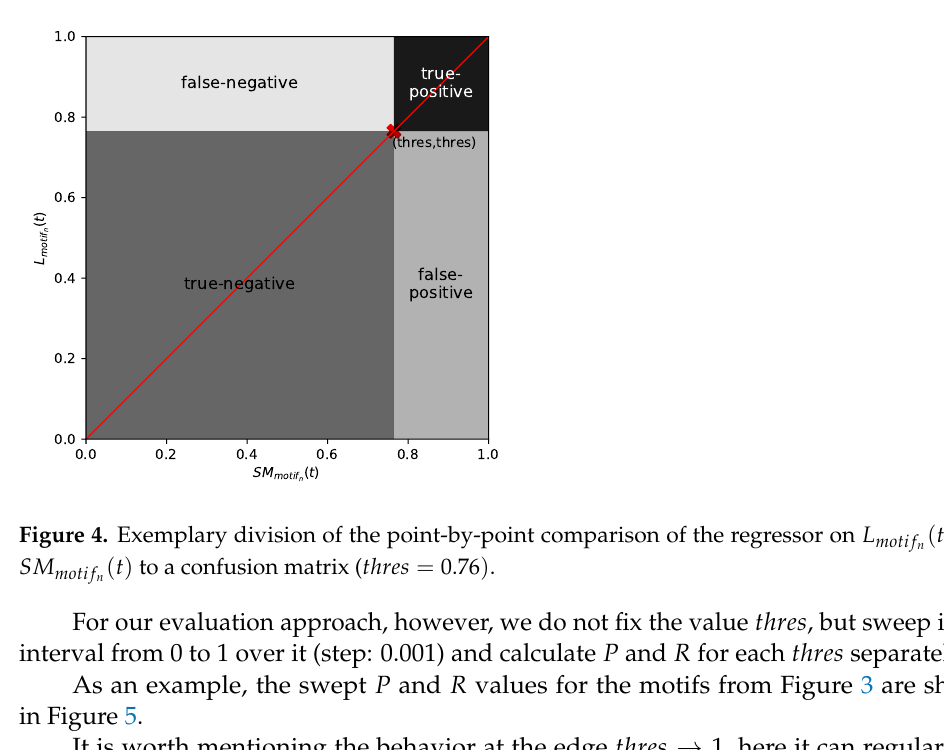
Figure 4. Exemplary division of the point-by-point comparison of the regressor on L motif ( t ) to a confusion matrix ( thres = 0.76 ) . SM motif n